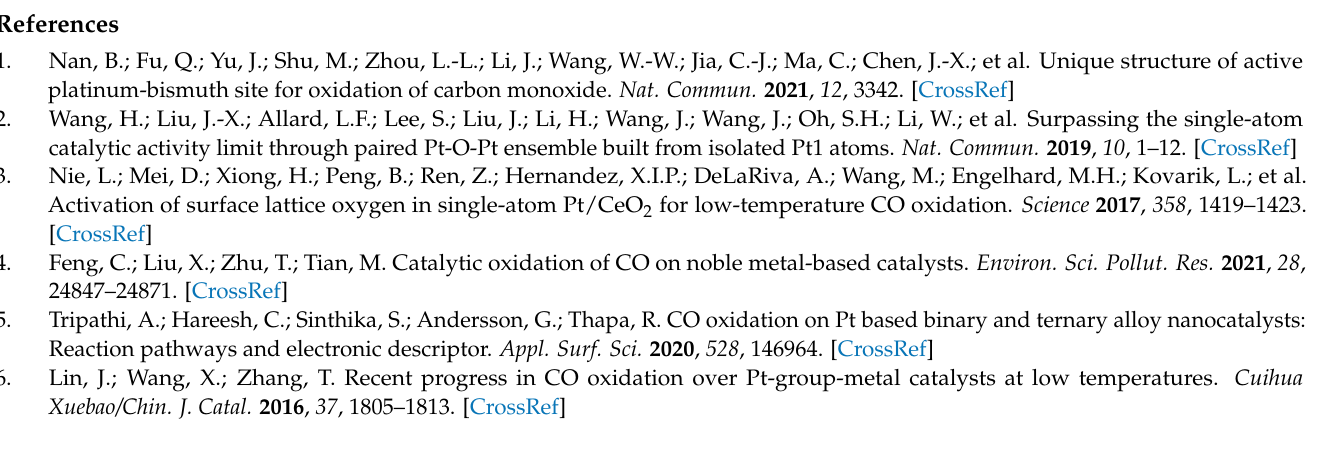
Figure S4. The peak intensity of CO 2 in the in situ DRIFT spectra of the CO adsorption–desorption– oxidation for Pt/TiO 2 , Pt/TiO 2 -H 2 , and Pt/TiO 2 -CO catalysts at 200 ◦ C. Figure S5. The peak intensity of CO 2 , the integrated peak area of carboxylate and bicarbonate as a function of temperature for (a) Pt/TiO 2 , (b) Pt/TiO 2 -H 2 , and (c) Pt/TiO 2 -CO. Figure S6: (a) Influence of NO on CO conversion as a function of reaction temperatures, and (b) apparent activation energy (E a ) calculated by the Arrhenius equation of Pt/TiO 2 , Pt/TiO 2 -H 2 , and Pt/TiO 2 -CO catalysts (R = 8.314 × 10 − 3 kJ/(mol · K)). Table S1: Crystal sizes of TiO 2 calculated by the Debye–Scherrer equation from the XRD patterns of Pt/TiO 2 , Pt/TiO 2 -H 2 and Pt/TiO 2 -CO catalysts. Table S2: Raman shift and full width at half maximum (FWHM) of TiO 2 E g vibration mode obtained from the Raman spectra of Pt/TiO 2 , Pt/TiO 2 - H 2 and Pt/TiO 2 -CO catalysts. Table S3: Desorption temperature during O 2 -TPD of oxygen species and H 2 consumption in H 2 -TPR experiment. Table S4: Vibration mode assignments of IR bands on DRIFTS of Pt/TiO 2 , Pt/TiO 2 -H 2 and Pt/TiO 2 -CO catalysts. Table S5: The T 100 and T 50 in the CO oxidation experiment over Pt/TiO 2 -CO and Pt/TiO 2 -CO oxidized in 2 vol. % O 2 /N 2 for 2 h at 200 ◦